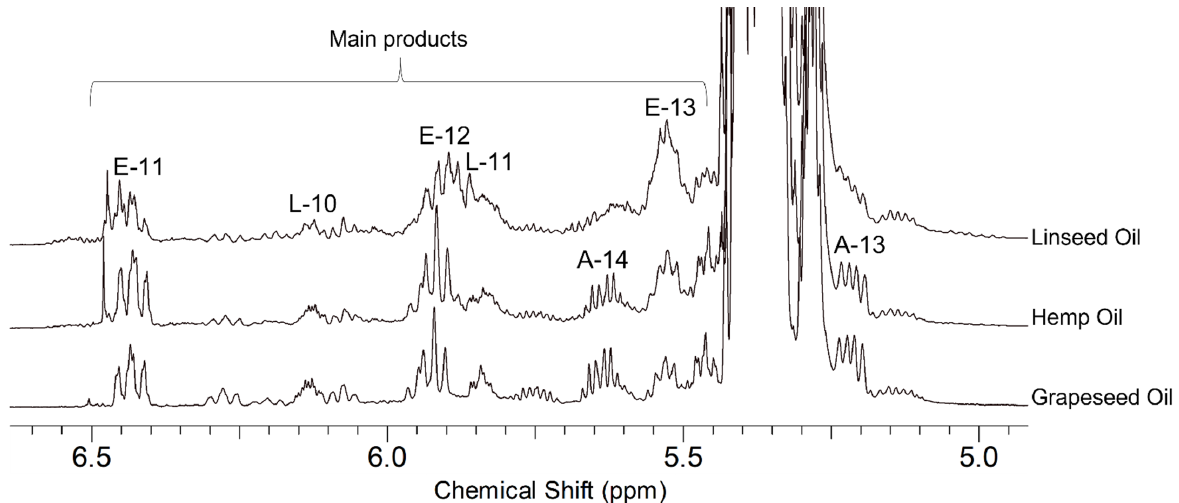
Figure 7. 1 H NMR spectral expansion of oil products with MA in the region of 6.6 -5.0 ppm. The signals have been attributed to the olefinic protons (numbers) of the adducts reported in Scheme 3 and Figure 5.